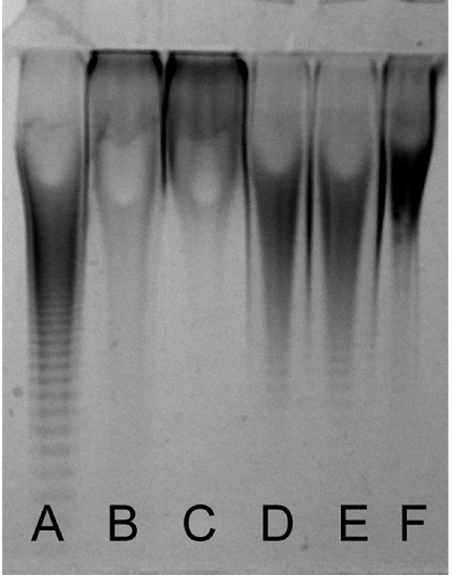
Table 2. The Molecular Weight of CS Preparations from Chinese Sturgeon Cartilage. The values in the brackets correspond to the uncertainties.